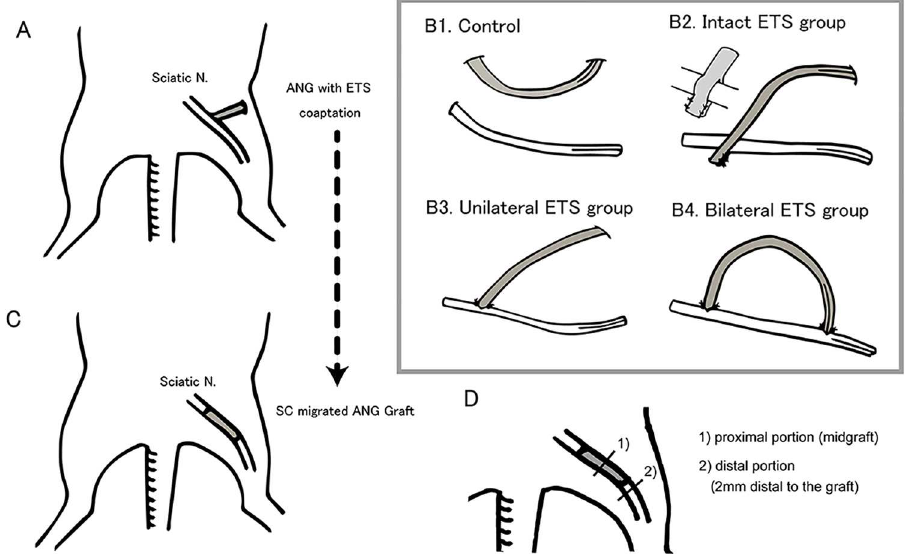
Fig 1. Schematic drawing of experimental model and design. A) Schematicdrawingof the experimental model for Schwanncell (SC) migration ability. Cold preservedacellular nerve allografts (ANGs)